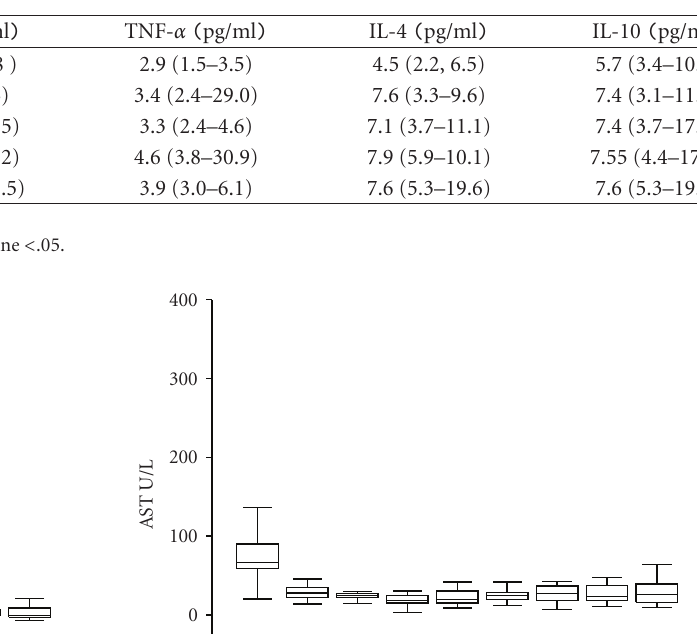
Table 6: Serum cytokine levels in the patients following adefovir dipivoxil treatment.